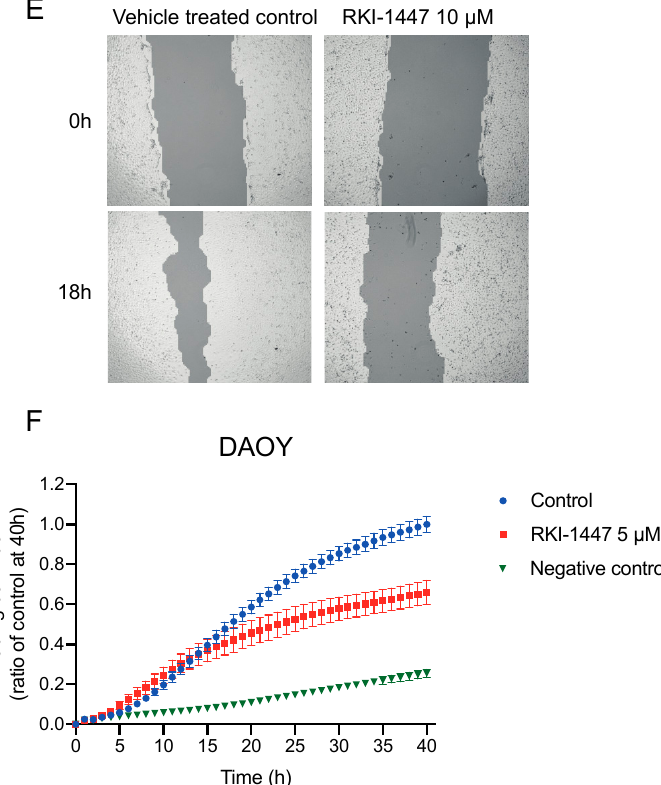
Figure 4. Inhibition of ROCK impairs the clonogenic capacity and migration / invasion of medulloblastoma cells ( A , B ) Tumorigenic capacity, shown as clonogenic forming ability, was inhibited in adherent medulloblastoma cell lines after 72 h of RKI-1447 exposure. RKI-1447 treatment in di ff erent concentrations were compared to vehicle control (one-way ANOVA with Bonferroni posttest p < 0.001 for both cell lines, DAOY: control vs. 0.31 µ M p = 0.055, 1.25 µ M p = 0.0089, 5 µ M p < 0.001, 20 µ M p < 0.001 and UW228-3: control vs. 0.31 µ M p = 0.013, 1.25 µ M p = 0.0043, 5 µ M p < 0.001, 20 µ M p < 0.001). IC 50 for DAOY was 1.43 µ M and 1.84 µ M for UW228-3, respectively. The treatments were tested in at least triplicates and the experiments were repeated three times. Mean with S.D. are displayed. ( C , D ) RKI-1447 inhibited medulloblastoma migration shown as the relative area of migrated cells 18 h after scratching, as measured by wound assay (one-way ANOVA with Bonferroni posttest, DAOY: p = 0.012, control vs. 5 µ M p = 0.053, control vs. 10 µ M p = 0.009 and UW-228-3: p < 0.001, control vs. 10 µ M and control vs. 20 µ M p < 0.001). Four images were acquired per treatment and the experiment was repeated three-four times. Values presented are mean with S.D. ( E ) Example images from wound assay on DAOY cells at 0 and 18 h, with analysis from TScratch software, acquired at 4 × objective. ( F ) RKI-1447 repressed the invasion ability in medulloblastoma cells. Real-time invasion analysis after treatment with 5 µ M RKI-1447 in DAOY cells in transwell cell chambers coated with 15% matrigel, monitored in the xCELLigence RTCA system (two-way ANOVA with Bonferroni post-Test, p = 0.021 for treatment over the 40 h period, p < 0.05 from 23 h and forward for both control vs. 5 µ M, p = 0.0005 40 h). The e ff ect on invasion from 10 µ M RKI-1447 are shown in Figure S5. Mean with S.E.M. of three independent experiments are shown. NS = non-significant, * p < 0.05, ** p < 0.01 and *** p < 0.001.